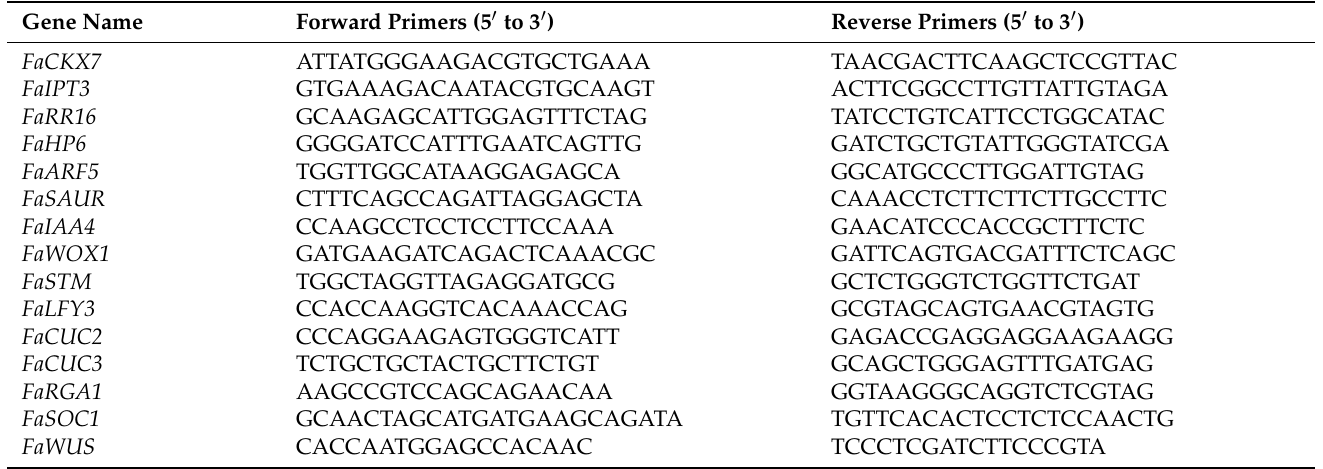
Table 1. Primers used for the quantitative RT-PCR.